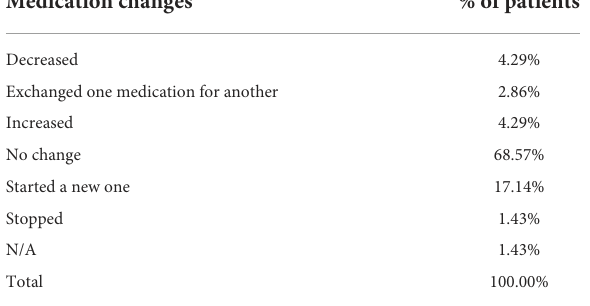
TABLE 10 Medication